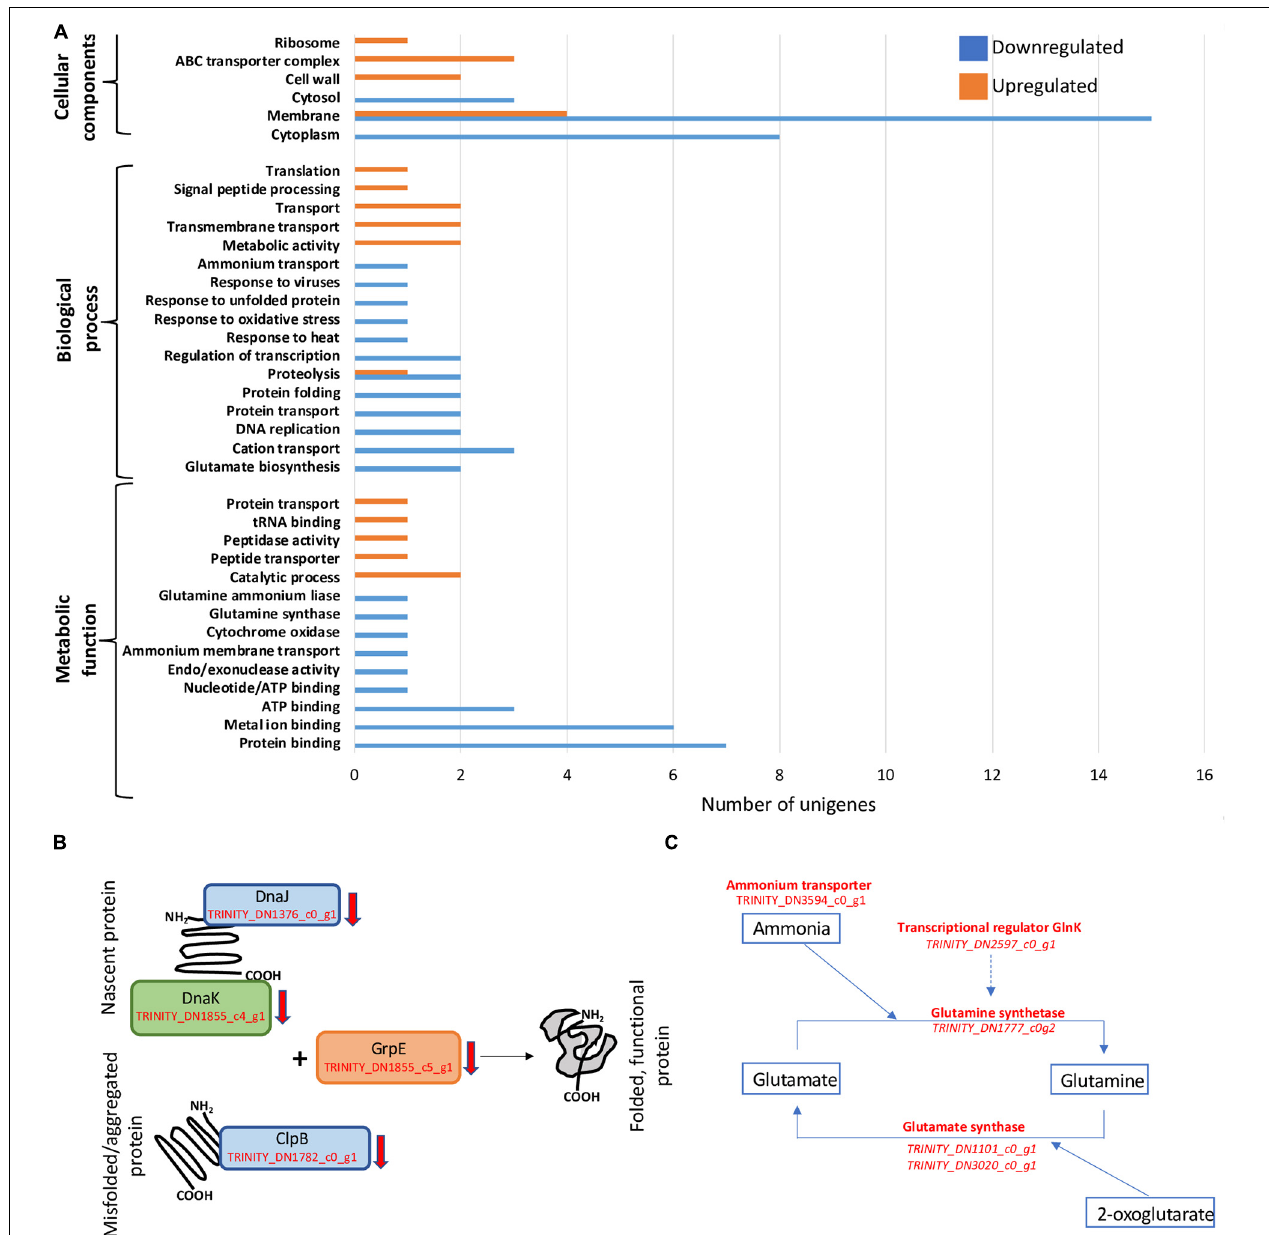
FIGURE 2 | General patterns of regulation and decrease in transcription of genes involved in protein folding and nitrogen acquisition. (A) Gene Ontology (GO) term enrichment analysis of D. radiodurans ’ 34-h cultures. (B) Downregulation of genes involved in protein folding and re-folding. (C) Downregulation of N-assimilation-related